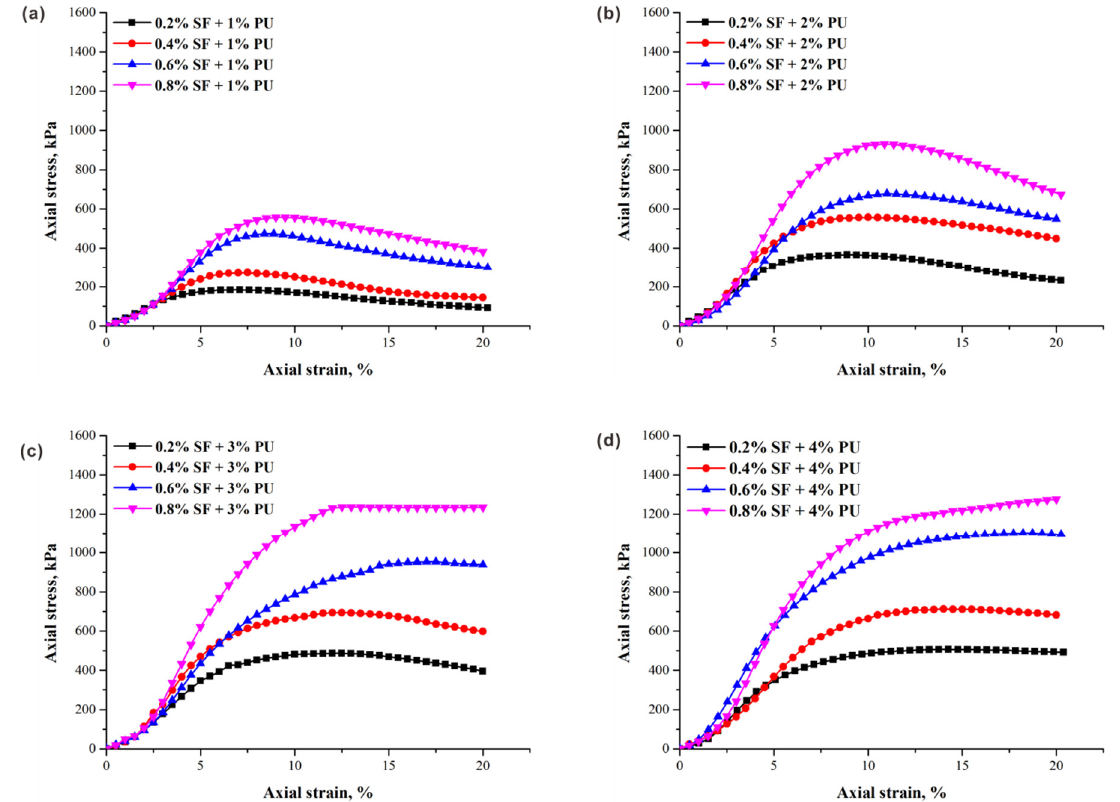
Figure 3. Typical stress–strain curves of specimens with varying sisal fiber content and ( a ) 1%